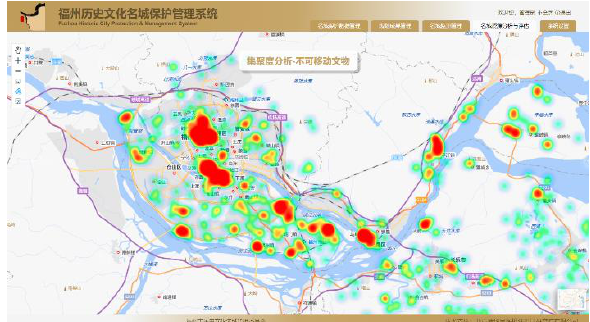
Figure 6. The aggregation analysis of the cultural relics